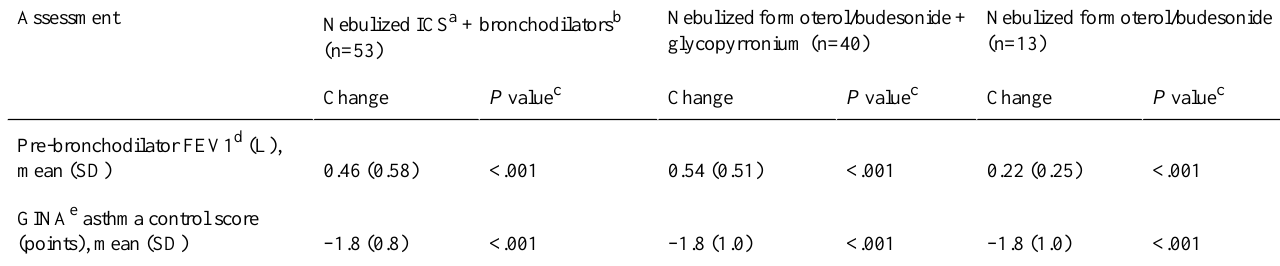
Table 2. Change in assessment values at 8 weeks, compared with baseline, for the overall group and by nebulized